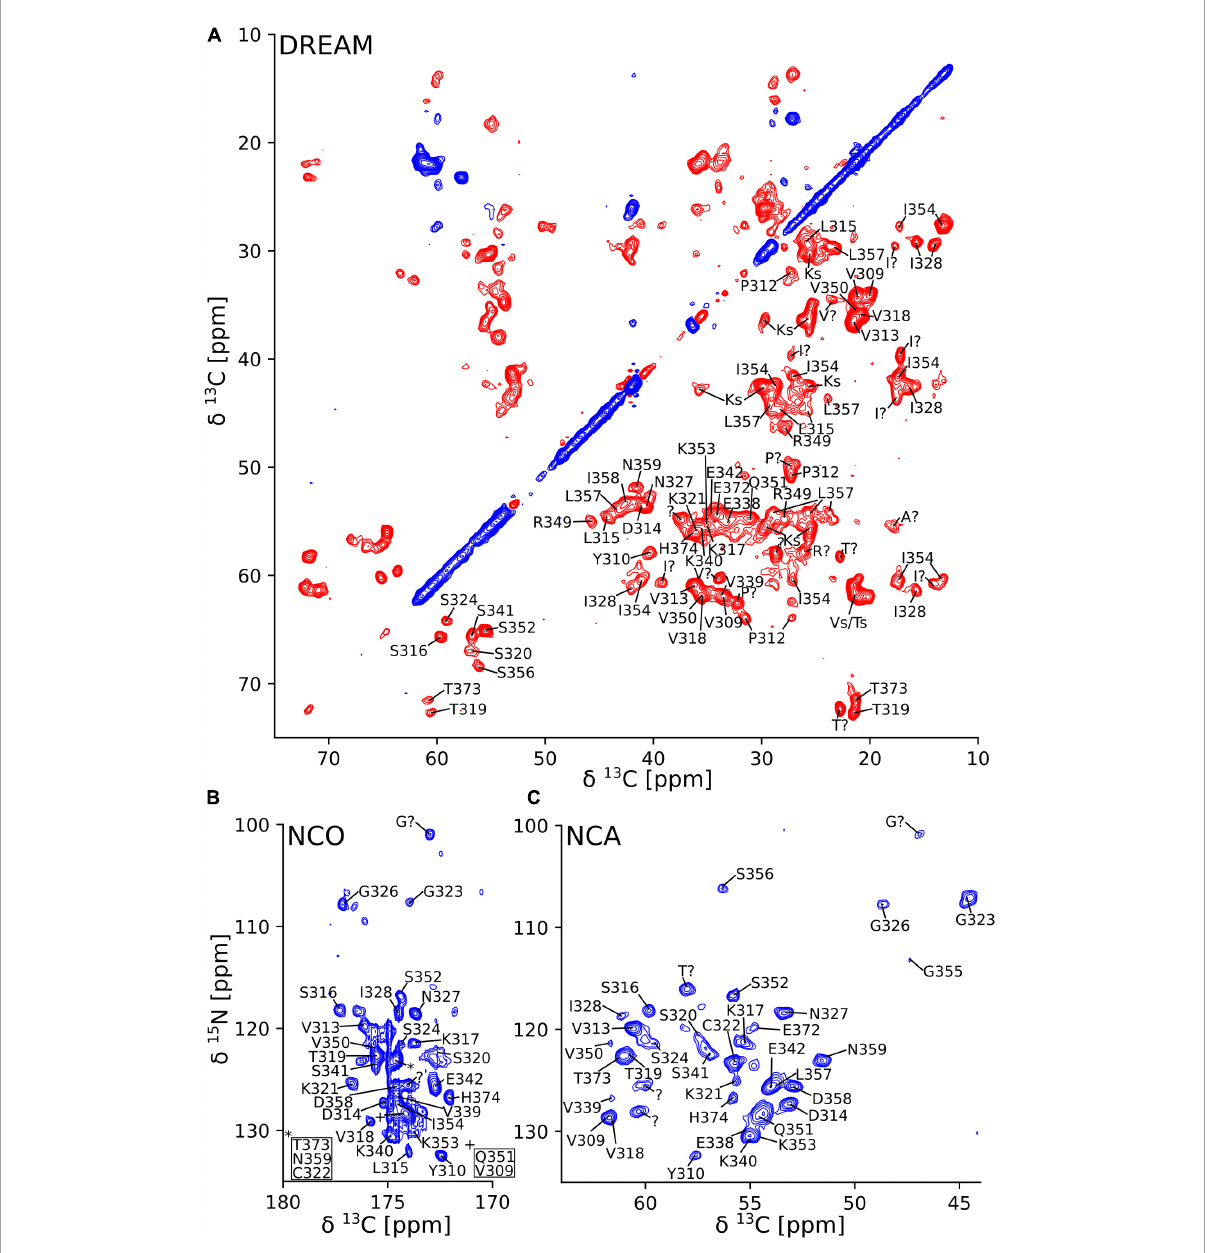
FIGURE2 Two-dimensional solid-state NMR spectra of tau(297-391) filaments made with DTT show narrow lines and one set of cross peaks indicative of a homogenous and well-ordered structure. (A) 2D 13 C- 13 C DREAM spectrum recorded at 35 kHz MAS. Negative and positive cross peaks are shown in red and blue, respectively. (B) 2D 15 N- 13 C NCO spectrum recorded at 35 kHz MAS using LOW BASHD decoupling during t 2 . (C) 2D NCA spectrum recorded under conditions similar to the NCO spectrum. Residue-specific resonance assignments are indicated showing an almost complete assignment of these